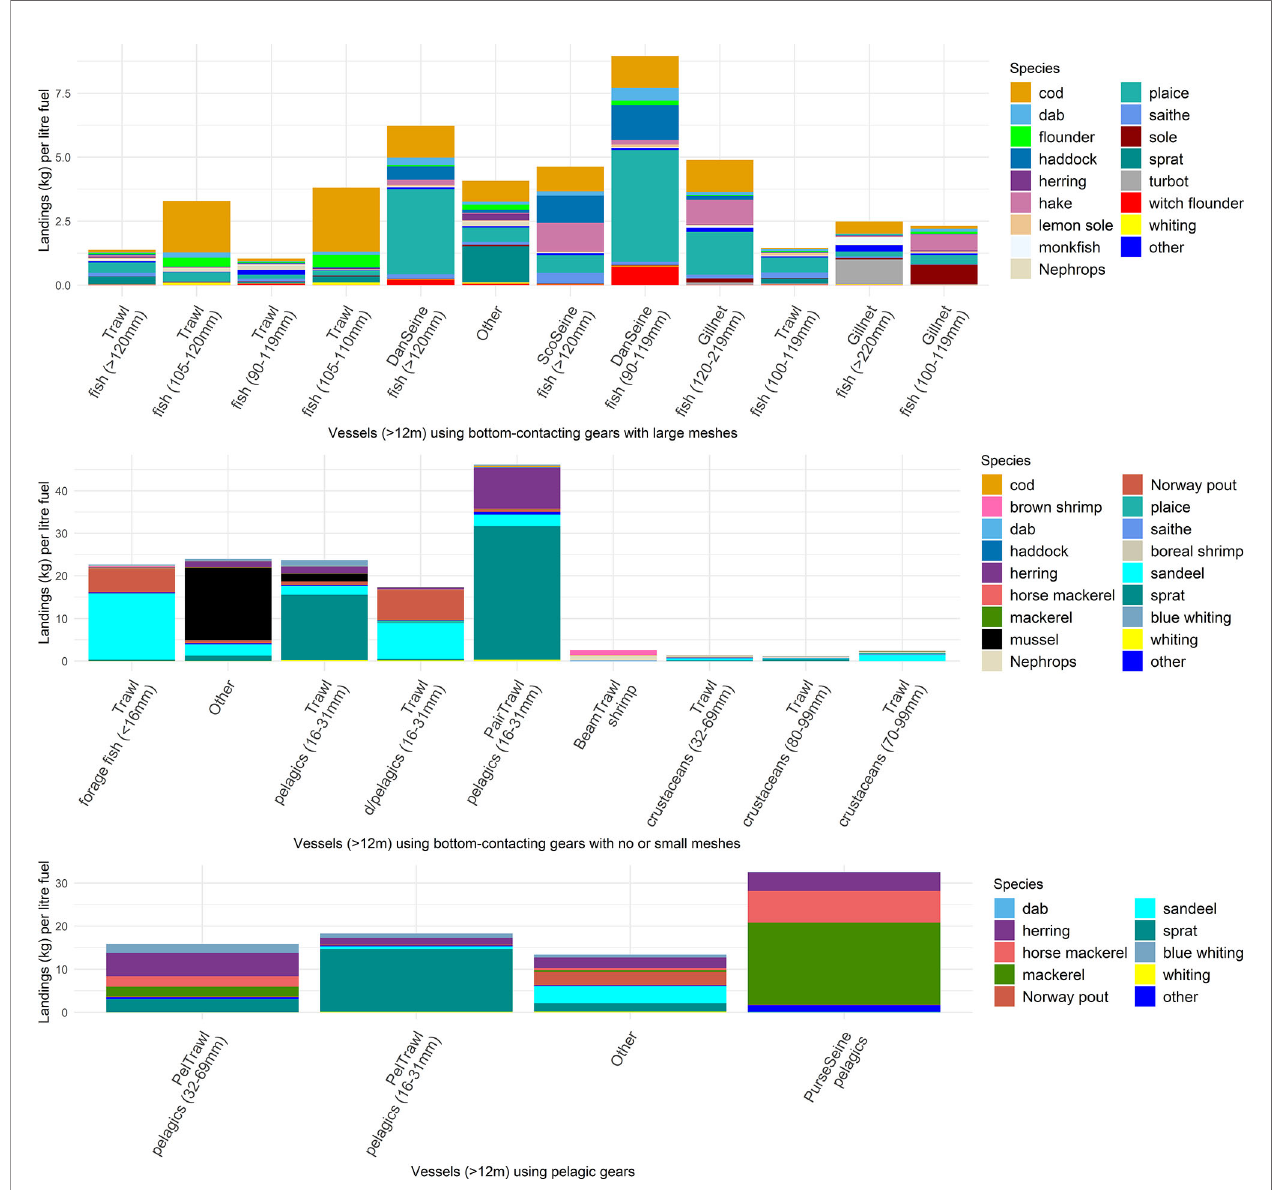
FIGURE 5 | Landings (kg) per litre of fuel consumed (CPUF) per fl eet-segment across species for large vessel using bottom contacting gears toward demersal species, or toward small forage fi sh, or for large vessel using pelagic gears. Fleet segments are ordered from left to right by landing volume. The overall CPUF estimates are sectored per species depending on their contribution to the total landing for each fl